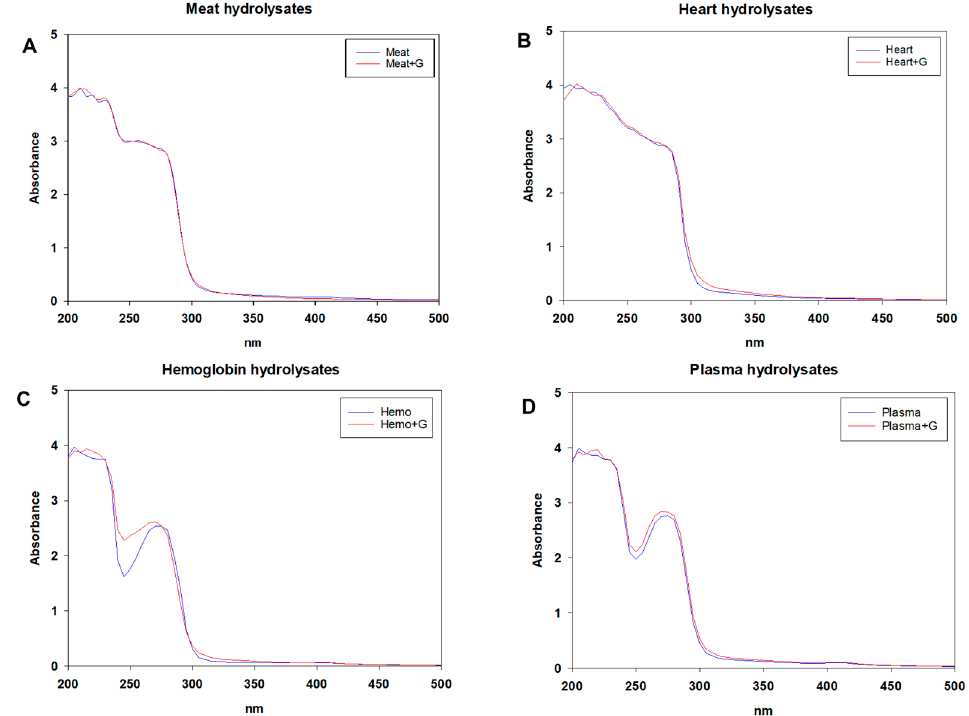
Figure 1. UV-scanning spectra of hydrolysates with (red) or without (blue) glucosamine (G) of ( A ) bovine meat, ( B ) bovine heart, ( C ) porcine hemoglobin, and ( D ) porcine plasma.